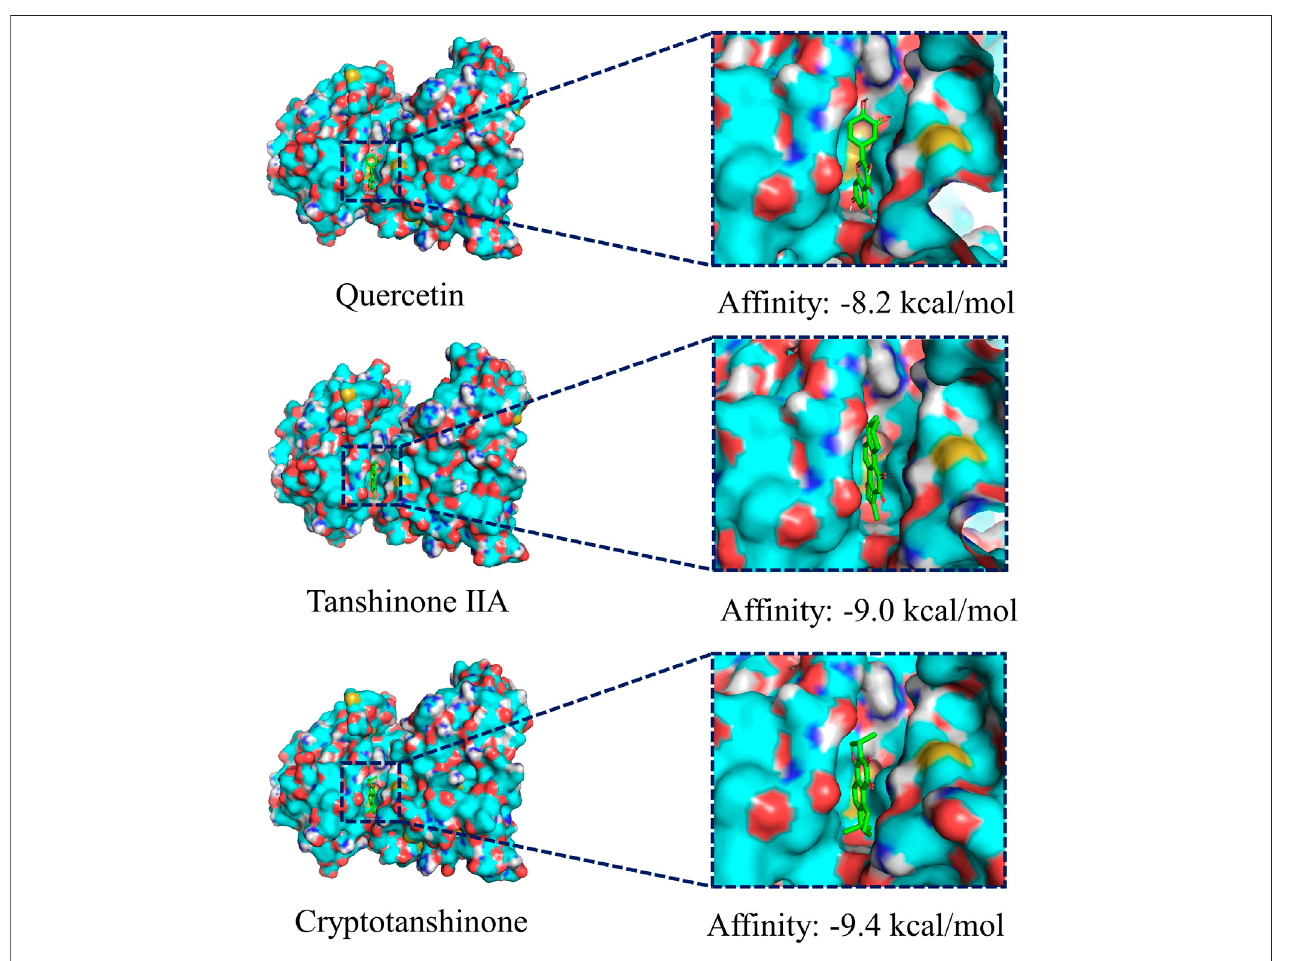
FIGURE4| MoleculardockingoftheingredientswithMAPKS(JNK).ThetopthreeingredientswiththelargestDCfromboththedatabaseandtheresultsofLC-MS analysis. The ligands (ingredient molecules) are shown in stick mode. The receptor is shown in surface model.